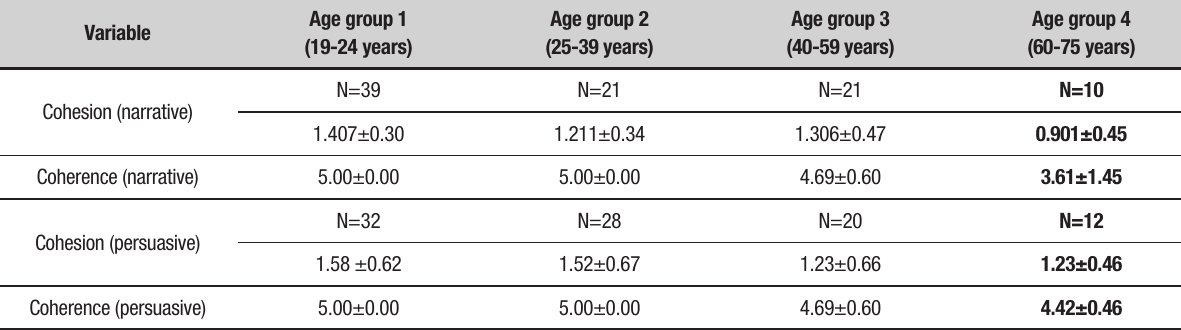
Table 3. Mean and standard deviation of values measured for subjects in different age groups.